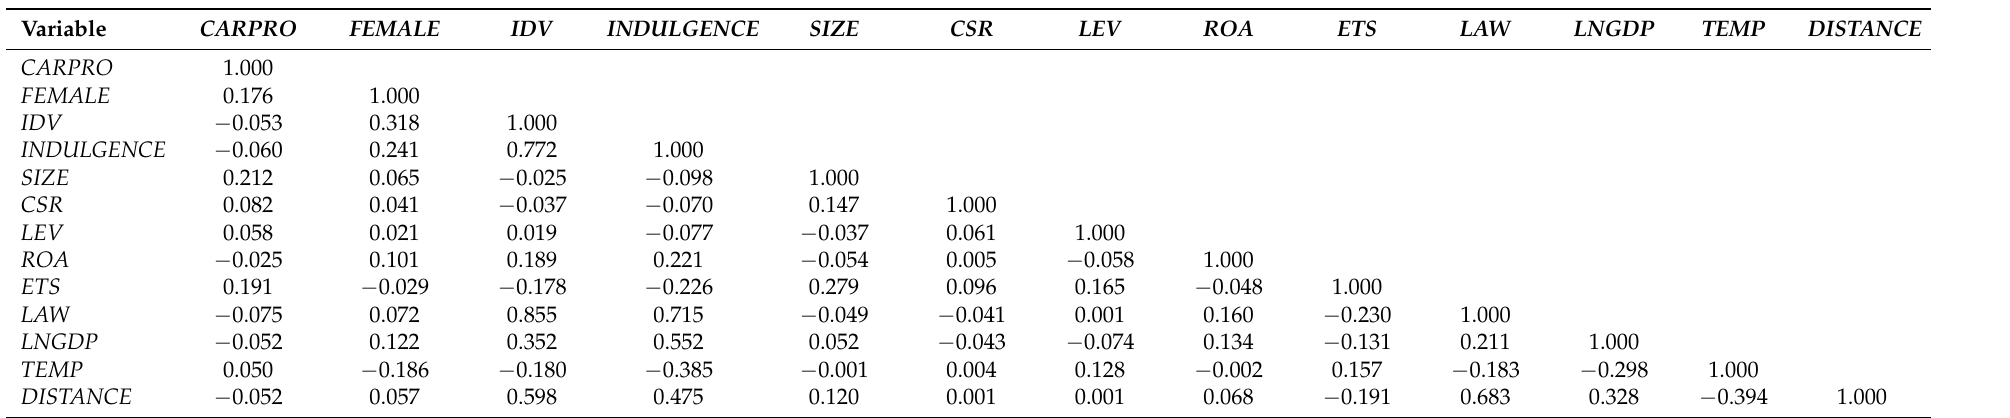
Table 5. Correlations (N =